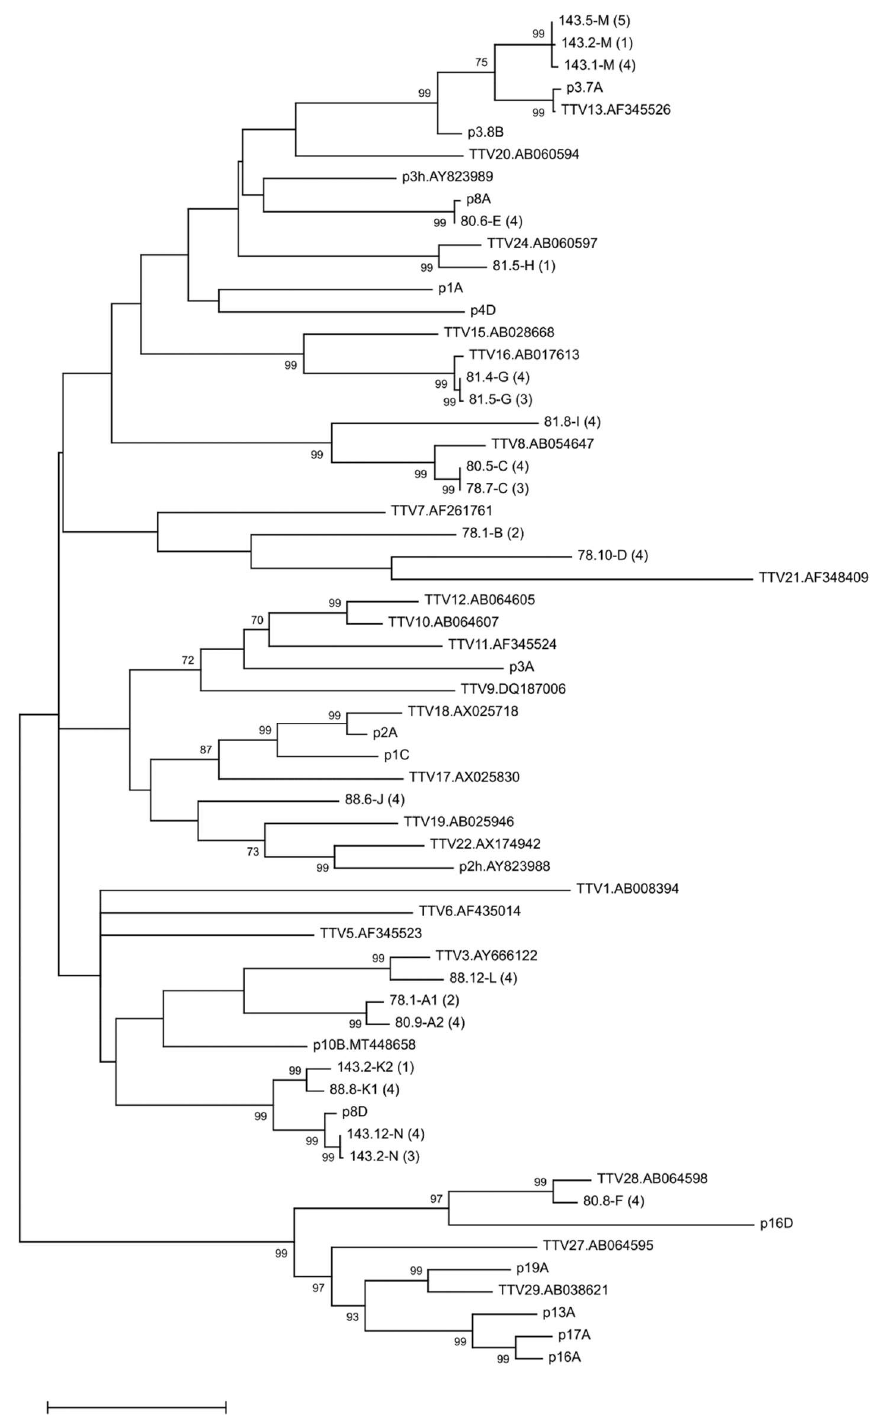
Figure 4. Phylogenetic tree of different TTV types. The tree includes (i) cloned and sequenced TTVs from the children (the number in parentheses depicts how many clones from the sample had the same sequence), (ii) all TTV-type species detected in humans, and (iii) all TTV clones/plasmids used in this study as controls for method development (marked as pXXX in the tree; see also Section 2.5.5). GenBank number of the previously published sequences is mentioned on the tree. The tree is made based on the ~500 nt region of ranging from the conserved UTR to close to the end of ORF2 (the multiplex PCR amplicon area). The phylogenetic tree was generated in MEGA X using the maximum likelihood method and general time reversible model, and bootstrap values were determined by 1000 replicates. Branch support values are given when >70.